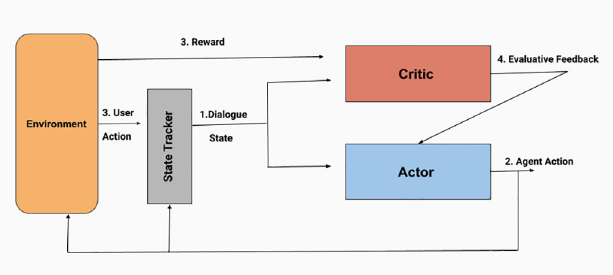
Fig 6. Actor Critic (AC) training